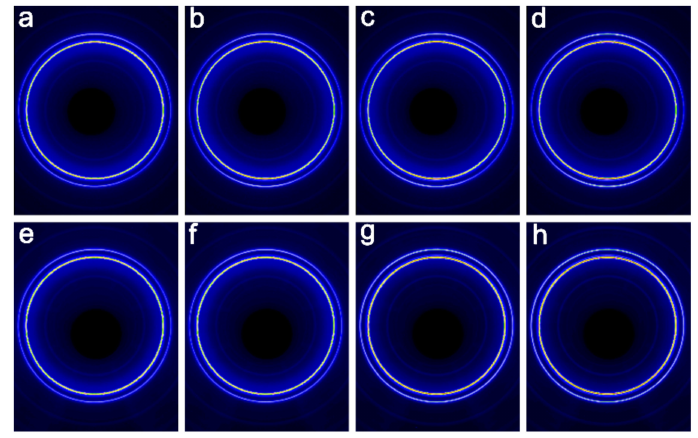
Figure 3. 2D-WAXD patterns of neat PCL and its nanocomposites: ( a – d ) 5 days; ( e – h ) 50 days.